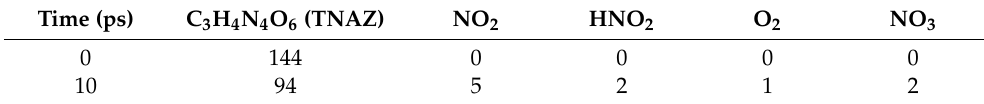
Table 1. Number of TNAZ molecules and other small molecules in the [100] direction.